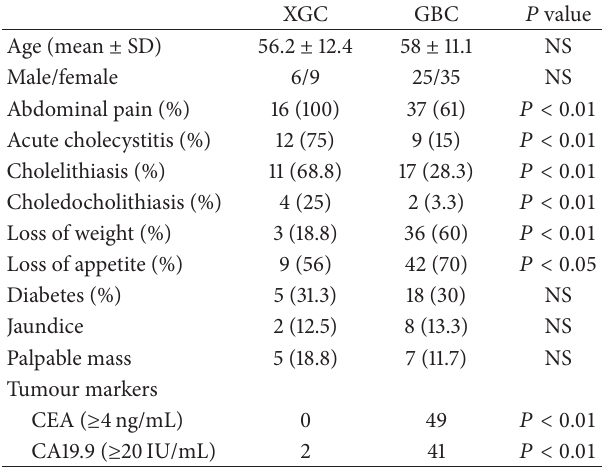
Table 1: Comparison of clinical features and tumour markers between XGC and